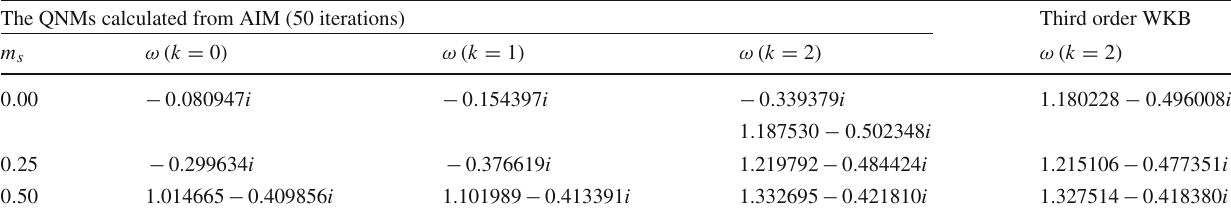
Table 4 The QNMs for scalar perturbations of a neutral black string for M = 1 ,α g = 1 ,(cid:14) = 0 ,α 2 m = − 0 . 16 ,γ = 1 . 5 ,λ = 1 The QNMs calculated from AIM (50